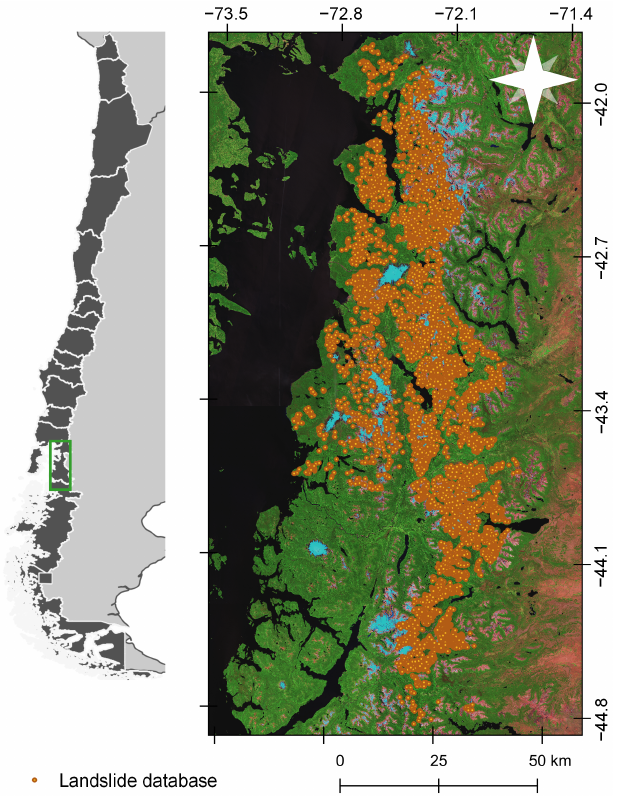
Figure 1. Location of the area of study. The points represent the datasets of landslides generated between 42–45°S along the Patagonian